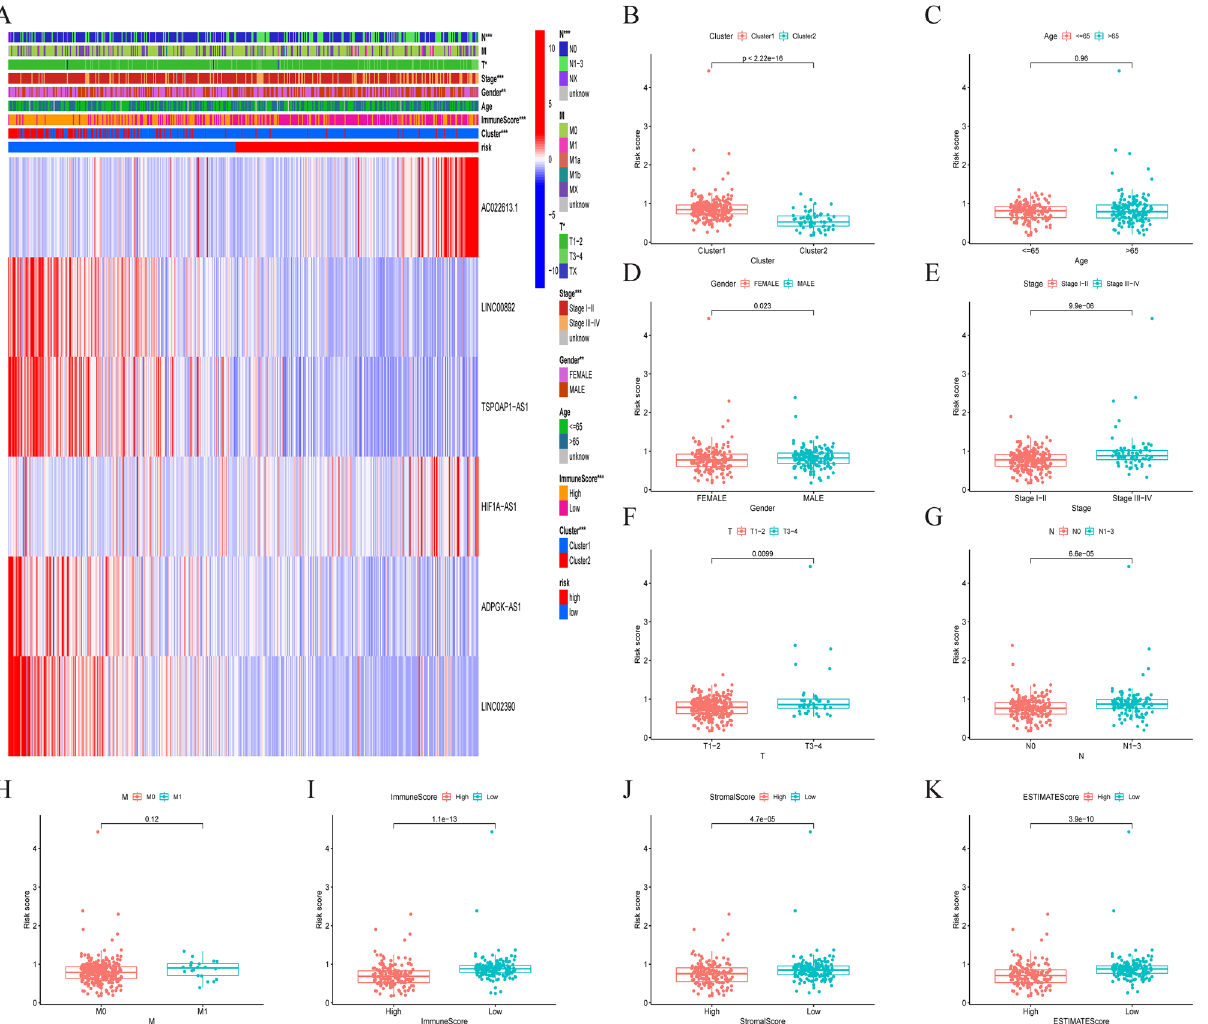
Figure 8. Estimation of the tumour immune microenvironment and clinical characteristics with the IClncRNA model in the entire TCGA cohort. ( A ) Heatmap of high- and low-risk groups defined by IClncRNA expression. ( B – H ) The relationship between the risk score and clinical characteristics. ( I – K ) Differences in the risk scores in the high and low tumour microenvironment score groups (ImmuneScore, StromalScore, and